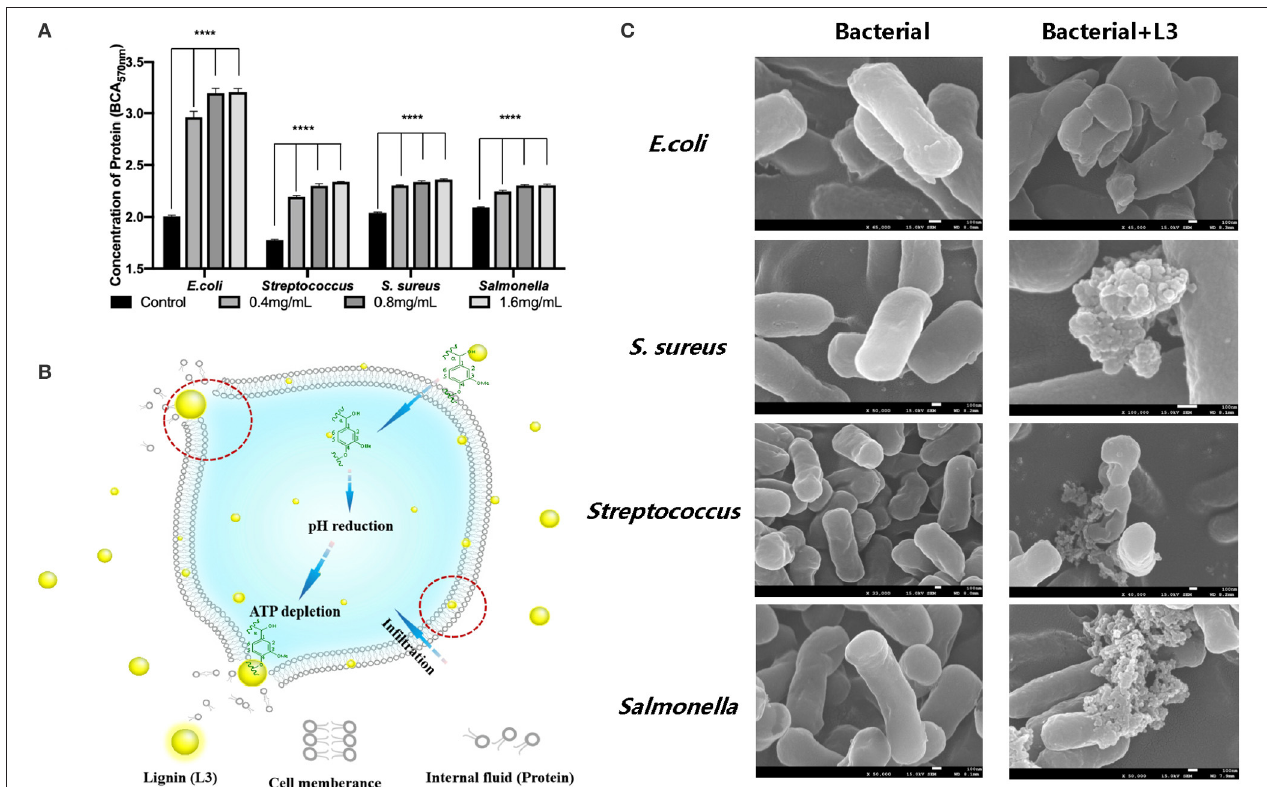
FIGURE 5 | The protein content in the culture solution of bacteria treated by the L3 lignin (A) ; the morphological image of the bacterial cell wall before and after treatment with the L3 lignin (B) ; the proposed antimicrobial mechanism of L3 (C) (**** p < 0.0001).